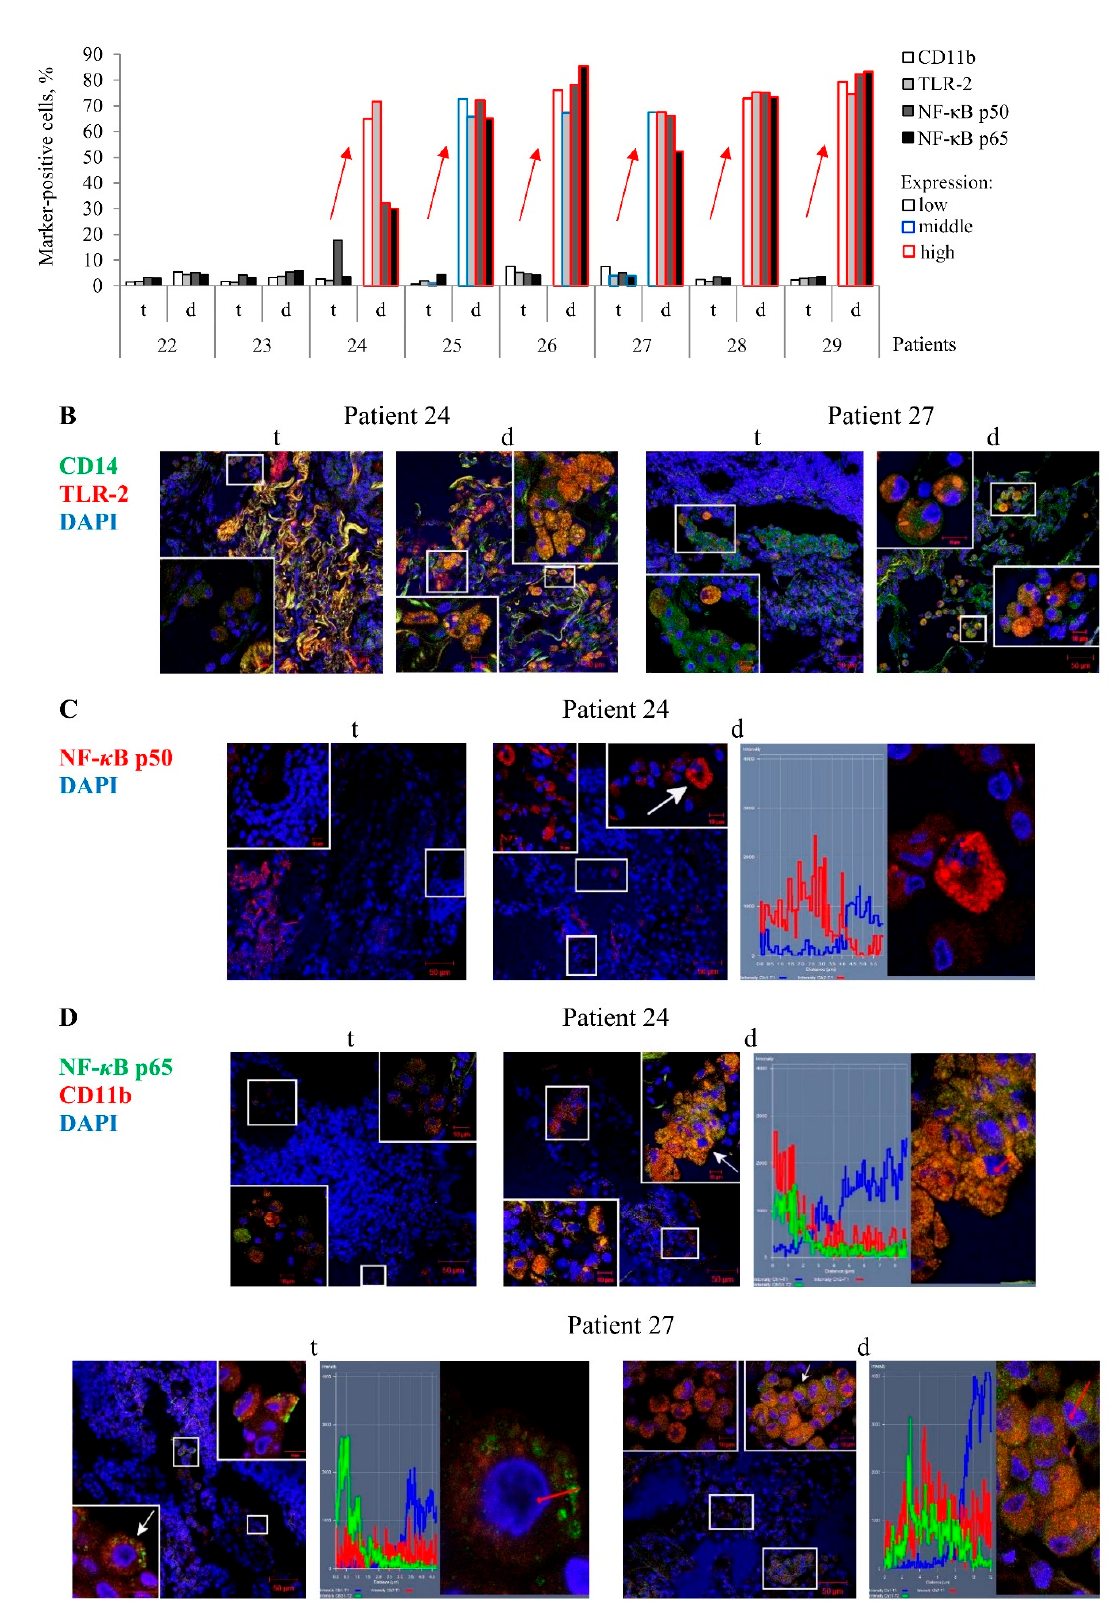
Figure 3. CD11b- and TLR-2-activated alveolar macrophages with an increased expression of the NF- κ B p50 and p65 subunits in them are detected on the histological sections obtained from the lung tissues distant from tuberculomas (d),